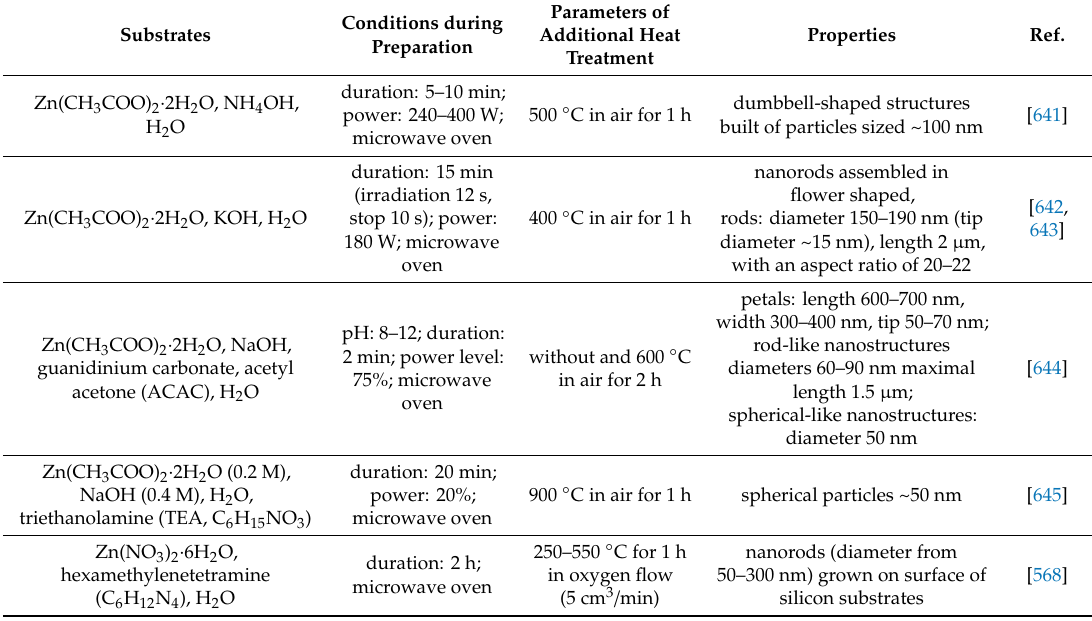
Table 6. Summary of microwave hydrothermal synthesis of ZnO nanostructures with additional heat treatment.